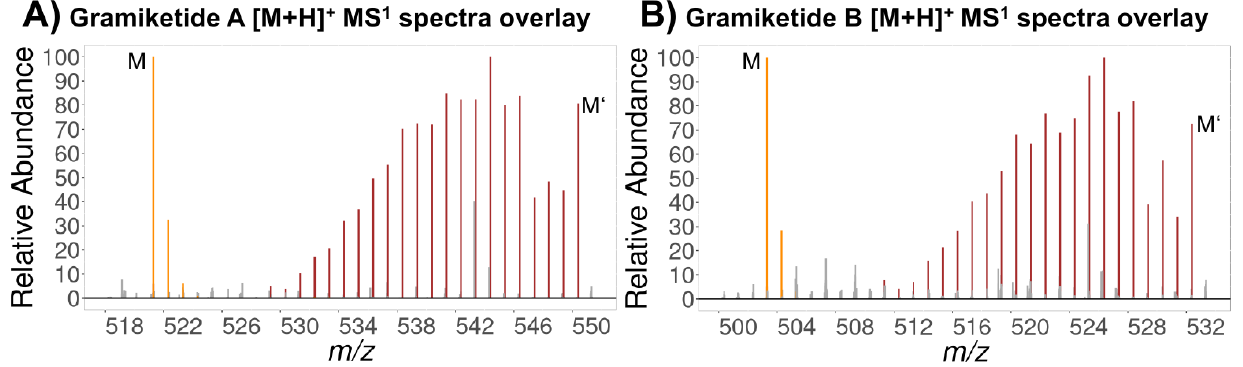
Figure 4. Average MS 1 [M + H] + ion spectra of gramiketide A ( A ) and gramiketide B ( B ) each showing an overlay of the native 12 C isotopolog pattern (orange) and 13 C labeled isotopologs with a varying number of 12 C tracer units incorporated (brown). Unrelated signals are shown in gray. Peak intensities were normalized to most abundant signals of 12 C and 13 C isotopologs, respectively.